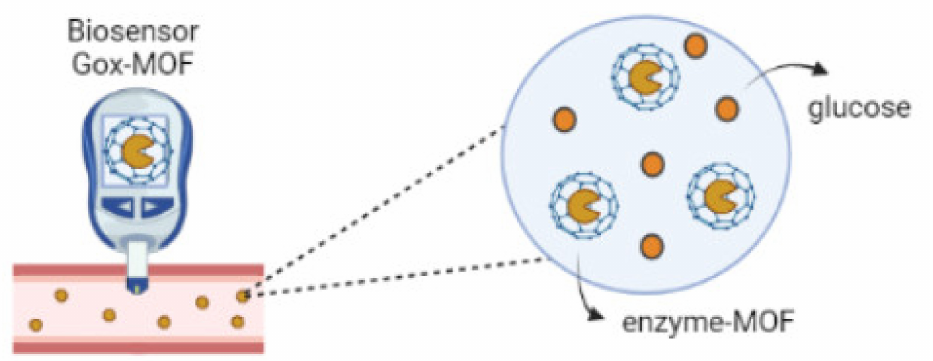
Figure 7. Enzyme–MOF biosensor for the ultra-sensitive detection of glucose levels in human serum, showing good reproducibility in experiments, wide detection range, and capacity of metabolization by the